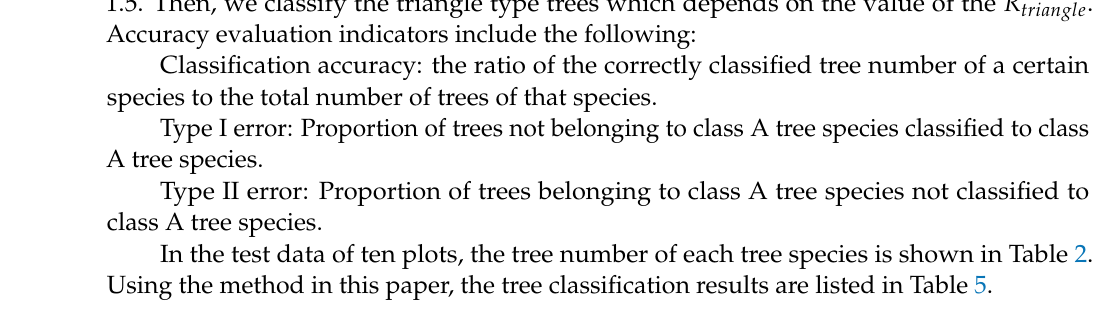
Table 5. The classification result comparation of the parallel-line shape fitting method and LiDAR Metrics.